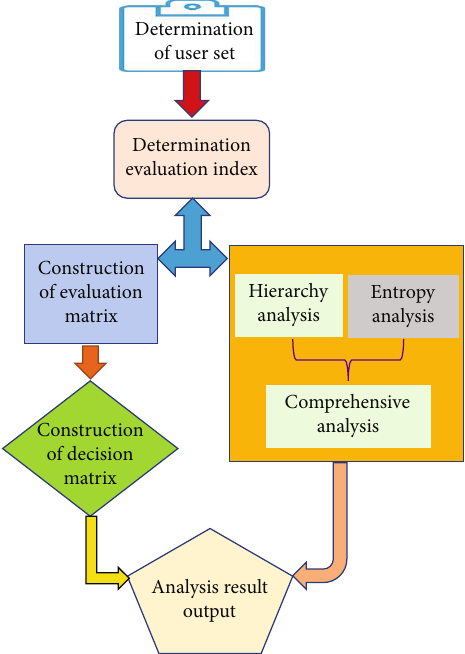
Figure 6: Design of evaluation